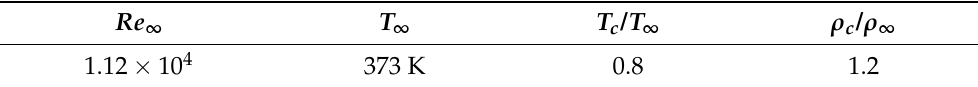
Table 2. Approximate experimental conditions.